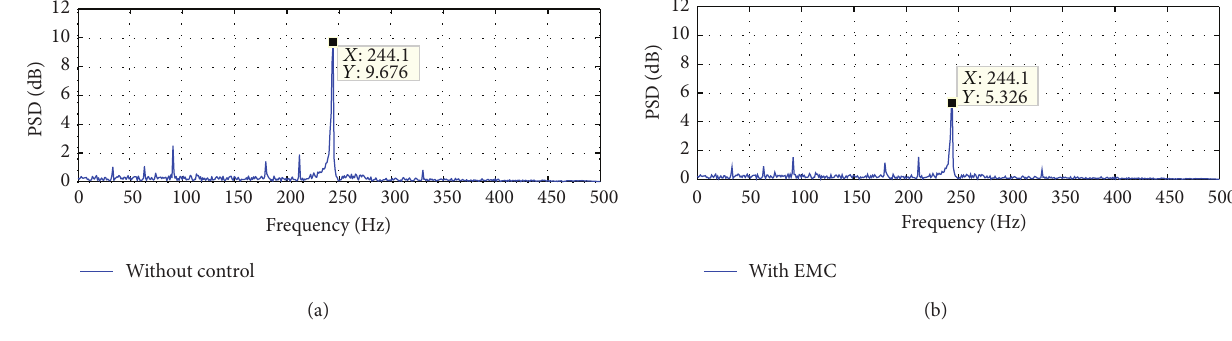
Figure 12: FFT of the second vibration mode of the first